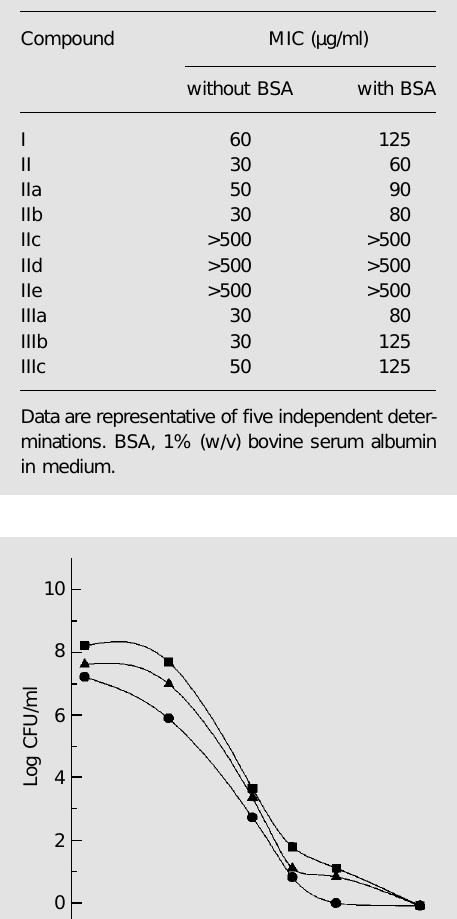
Table 3. Minimal inhibitory concentration (MIC) of naphthoquinones against Staphylococcus aureus .